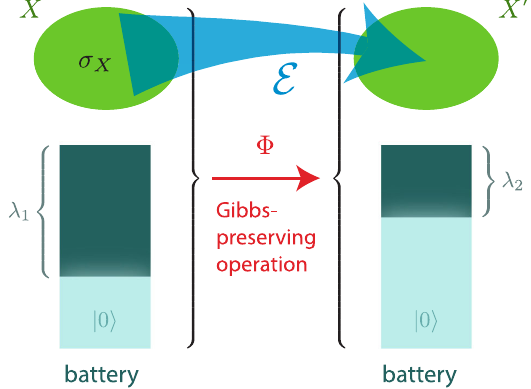
FIG. 1. Implementation of a logical process E (any quantum process) using thermodynamic operations. The process acts on X and has output on X 0 , and is implemented by acting on the system and the battery with a joint Gibbs-preserving operation. The battery starts with a depletion state λ 1 and finishes with a depletion state λ 2 . The overall extracted work is given by the difference λ 1 − λ 2